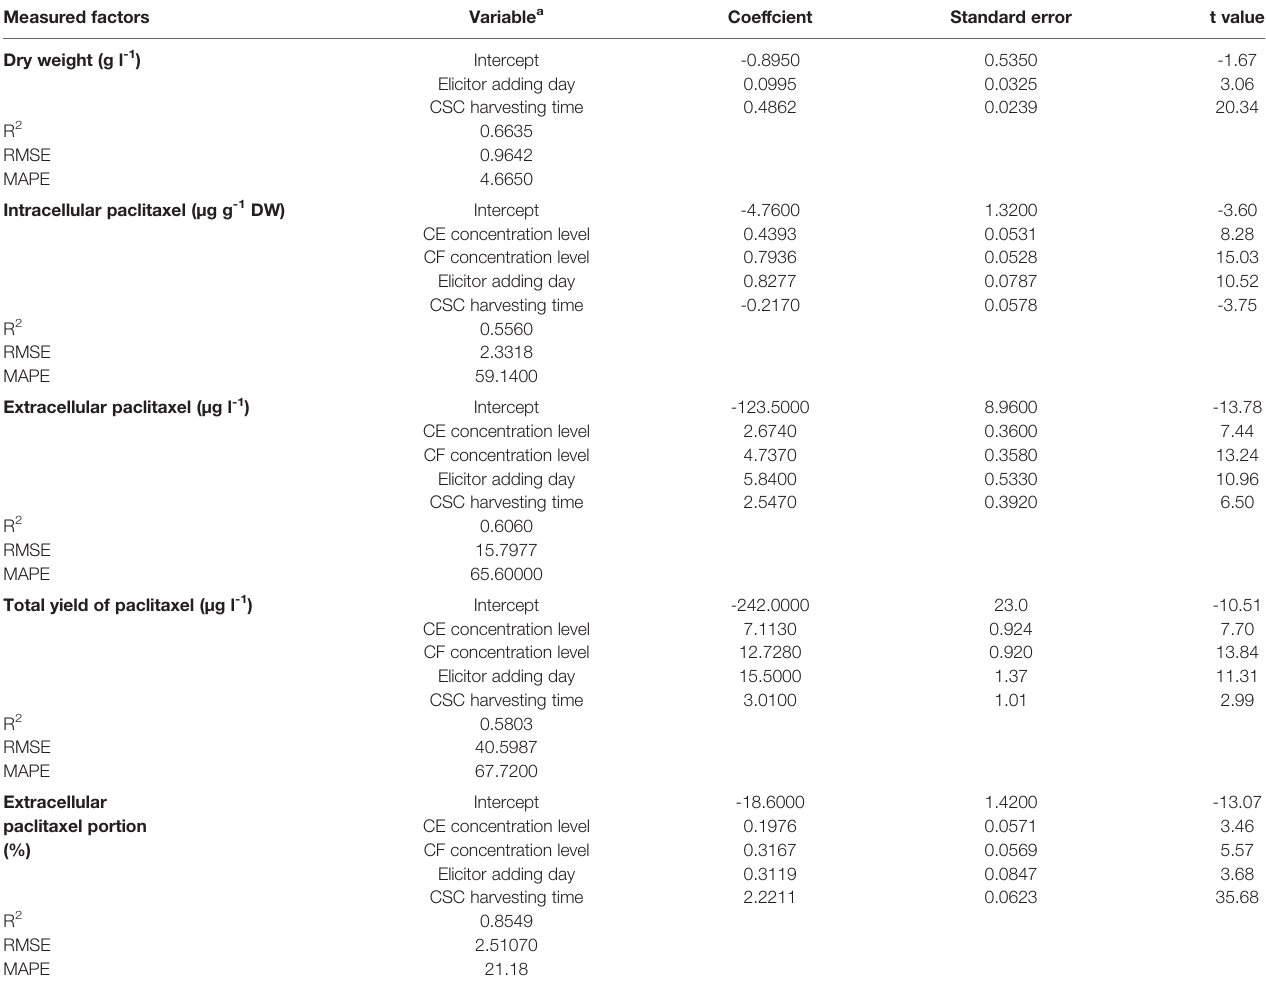
TABLE 1 | Backward regression models for estimating growth, paclitaxel biosynthesis, and secretion in Corylus avellana cell suspension culture (CSC) treated with fungal elicitors using cell extract (CE) and culture fi ltrate (CF) concentration levels [% (v/v)], elicitor adding day, and CSC harvesting time (day). Measured